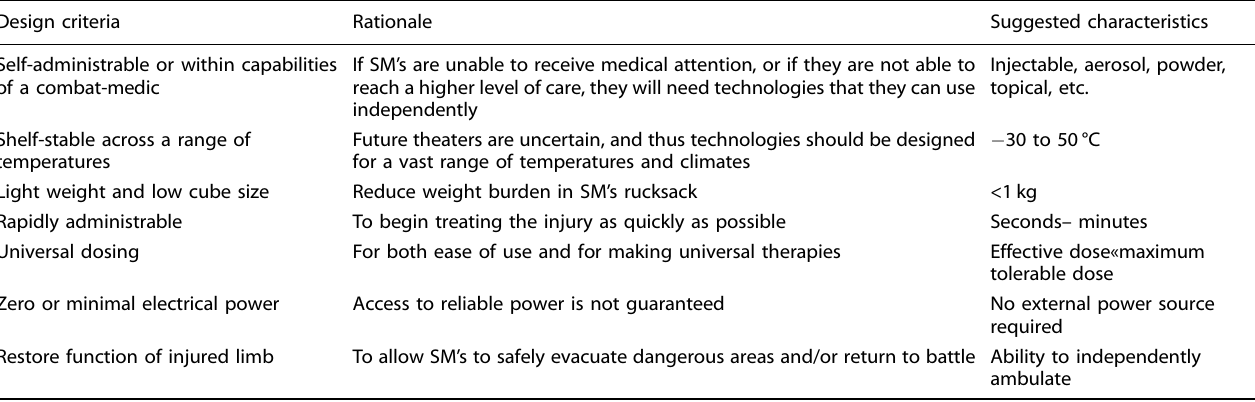
Table 1. Design criteria for biologically focused technologies to be developed for use in